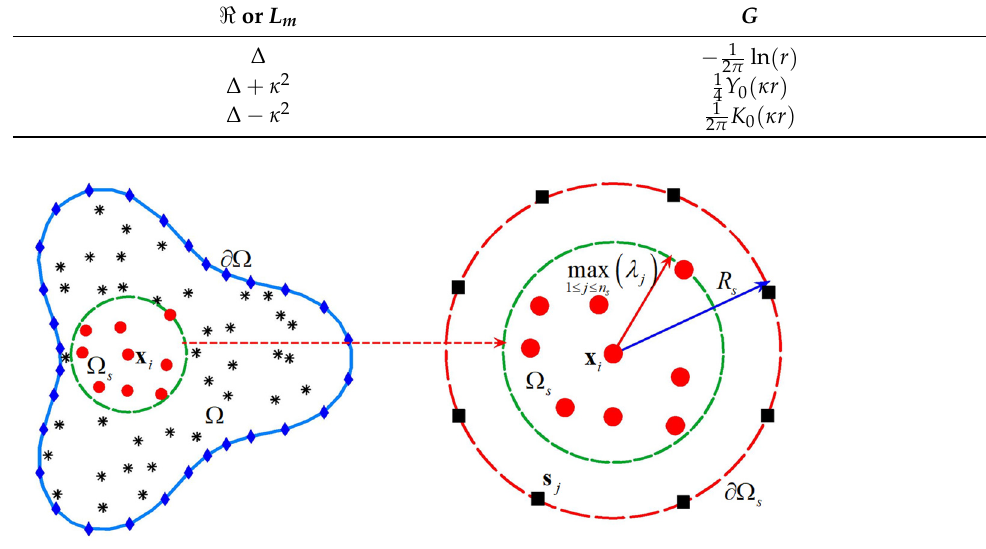
Figure 2. Schematic of a local domain Ω